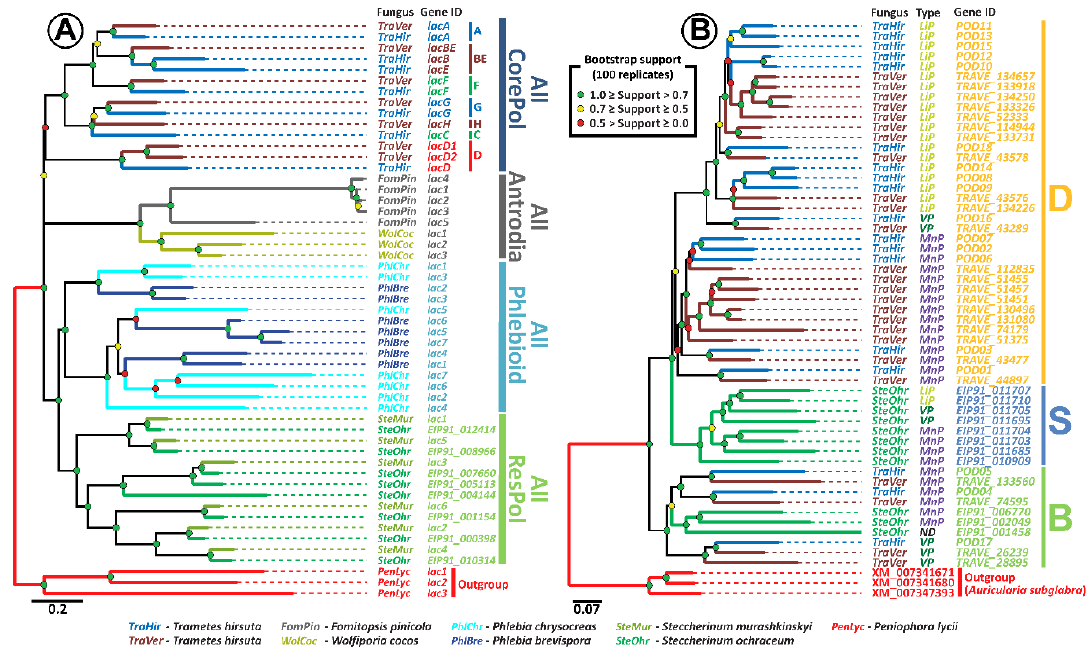
Figure 3. ( A ) Maximum likelihood (ML) phylogenetic tree of laccase genes (tree annotation is consistent with those from more general tree in [58]). ( B ) ML phylogenetic tree of peroxidase genes (tree annotation is consistent with those from more general tree in [59]).